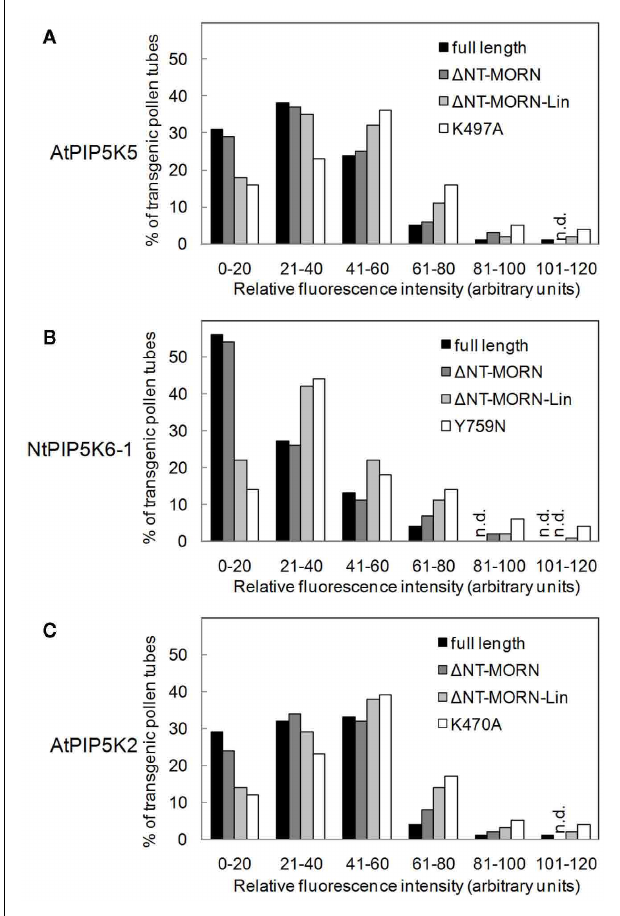
FIGURE 5 | Similar fluorescence intensity patterns upon overexpression of truncated variants ofAtPIP5K5, NtPIP5K6-1, or AtPIP5K2 in pollen tubes. The fluorescence intensities during overexpression of truncated variants of AtPIP5K5, NtPIP5K6-1, or AtPIP5K2 on pollen tube growth were determined (gray bars, as indicated). Fluorescence intensities were also scored for full-length controls (black bars) and catalytically inactive variants (white bars). (A) , AtPIP5K5 and derived proteins; (B) , NtPIP5K6-1 and derived proteins; (C) , AtPIP5K2 and derived proteins. Data are means ± SD from four independent transformation experiments and represent ≥ 300 transgenic pollen tubes observed for each construct. n.d., Not